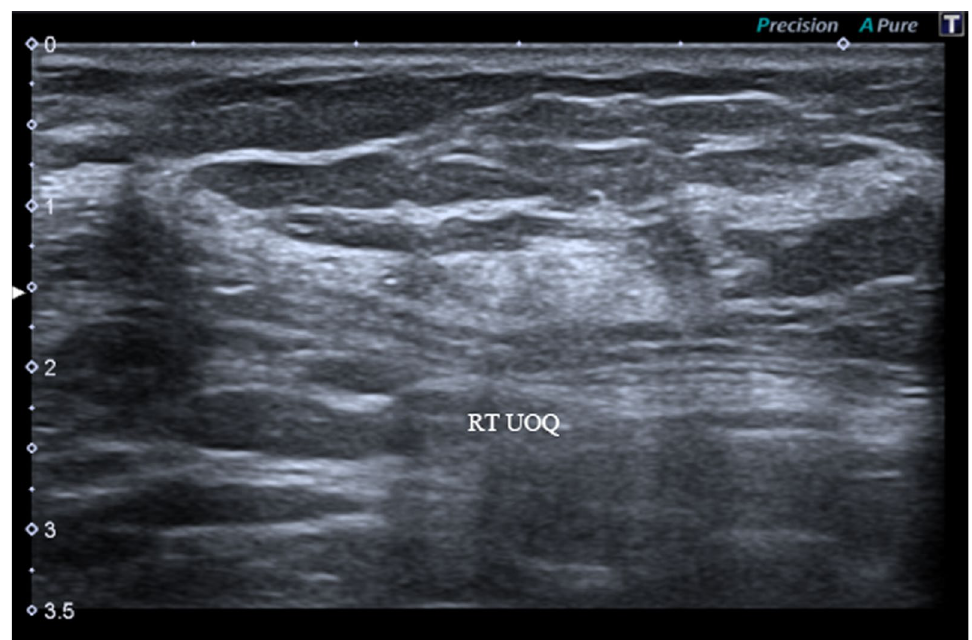
Fig. 3 Repeat ultrasound of the upper outer quadrant of right breast which confirmed the absence of previously seen beaded appearance of the superficial lateral thoracic vein. This confirmed resolution of the superficial thrombophlebitis of her right